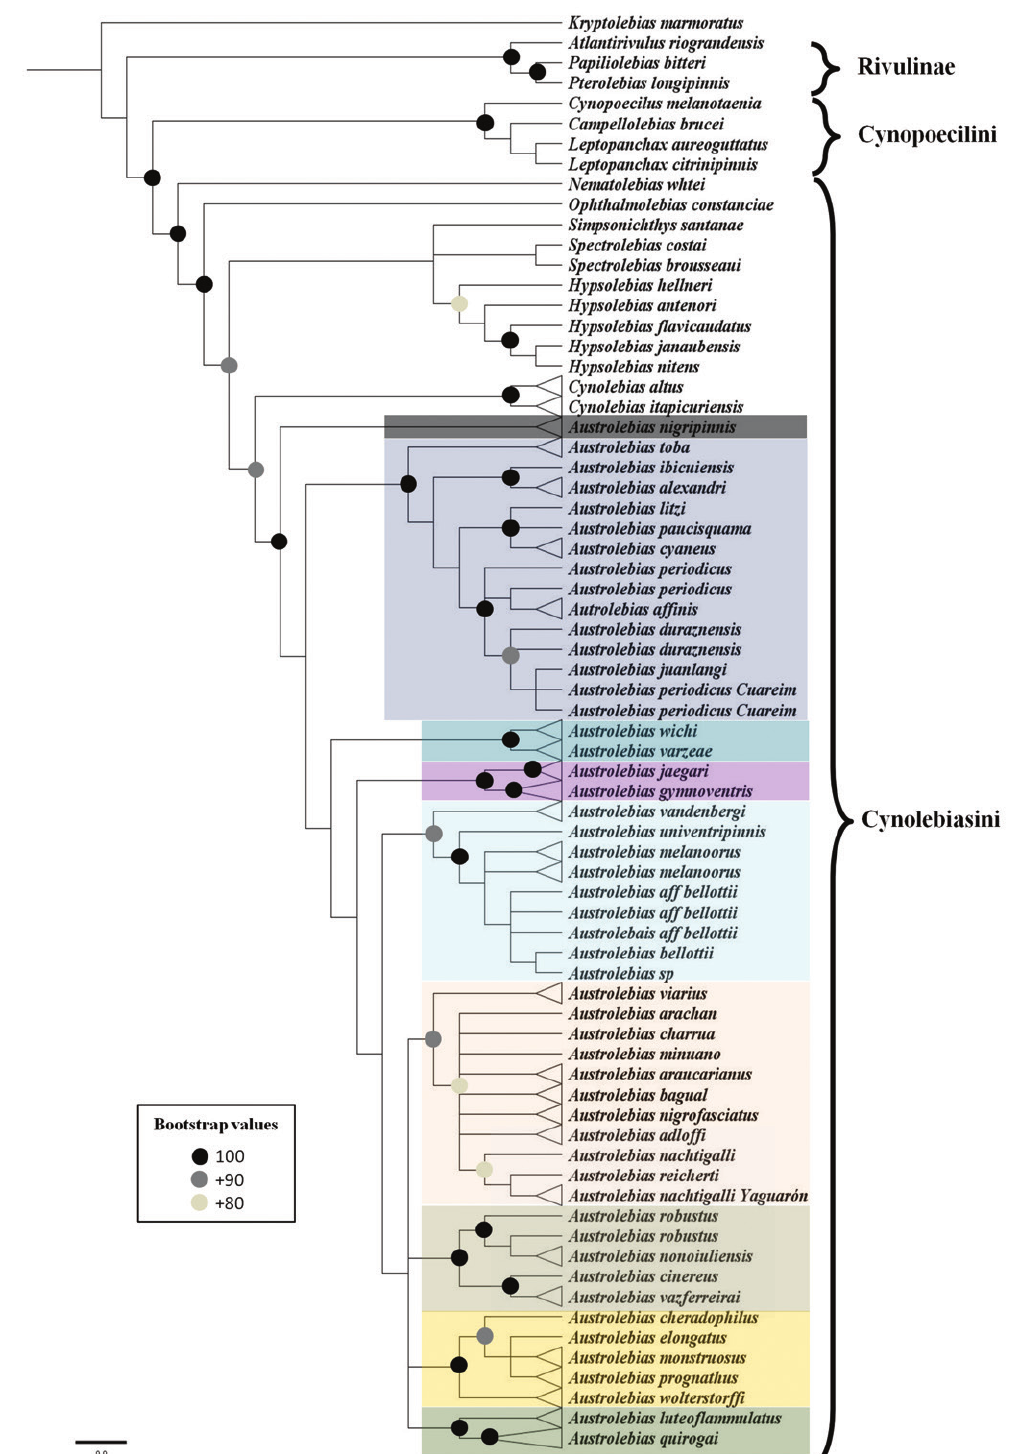
Fig. 11. Maximun parsimony phylogenetic tree of Austrolebias , based on molecular (ribosomal unit 16s, Cytochrome b, RAG1, Glyt) and morphological characters. Colored areas same as Fig.